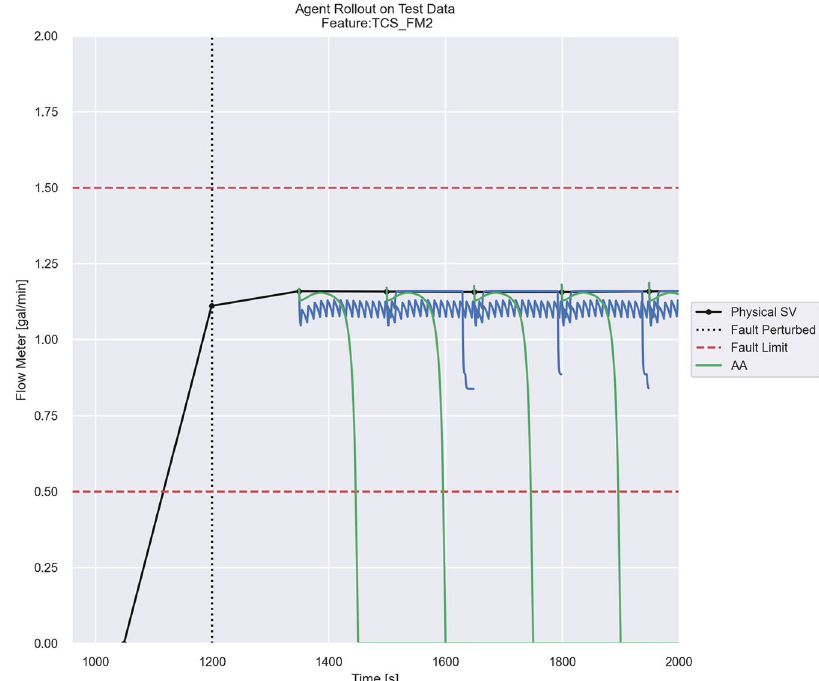
Fig. 6 ReLAA rollout shown for TCS fl ow meter 2. A successfully trained ReLAA issues actions to the system which allow for faulted operation: the reduction in fl ow (outside of satisfactory operating bounds shown in red) throughout the TCS as shown in green.